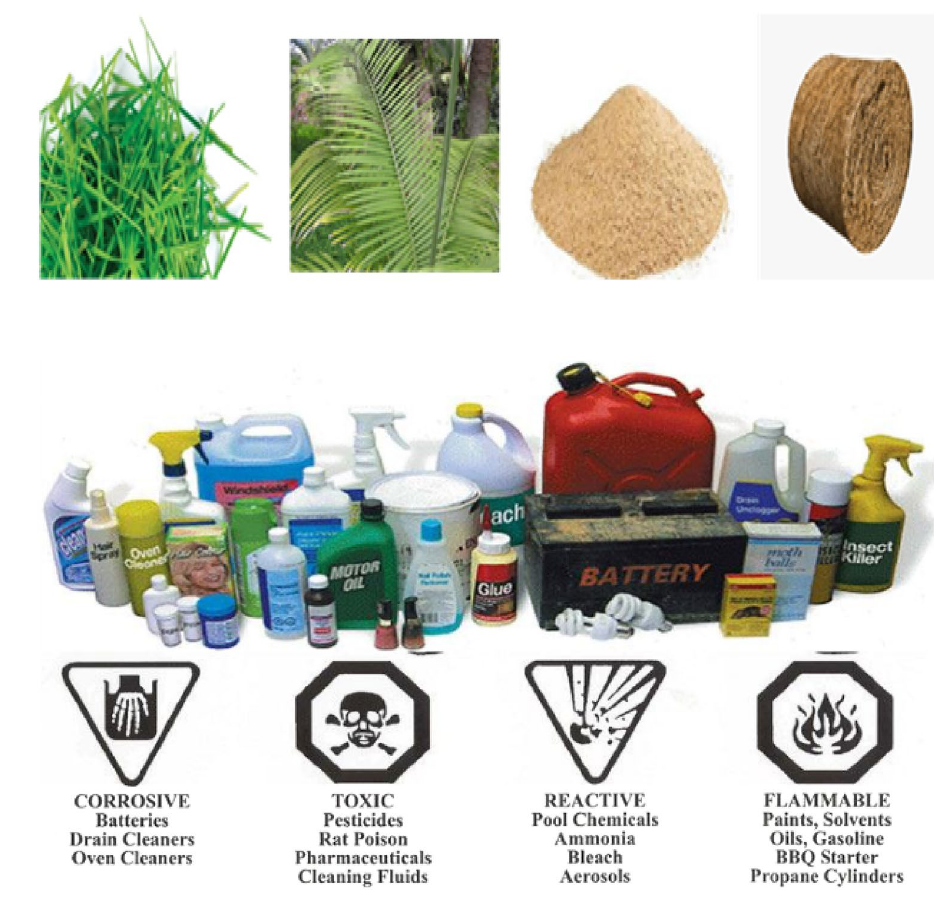
Fig. 2 Non-food waste materi-